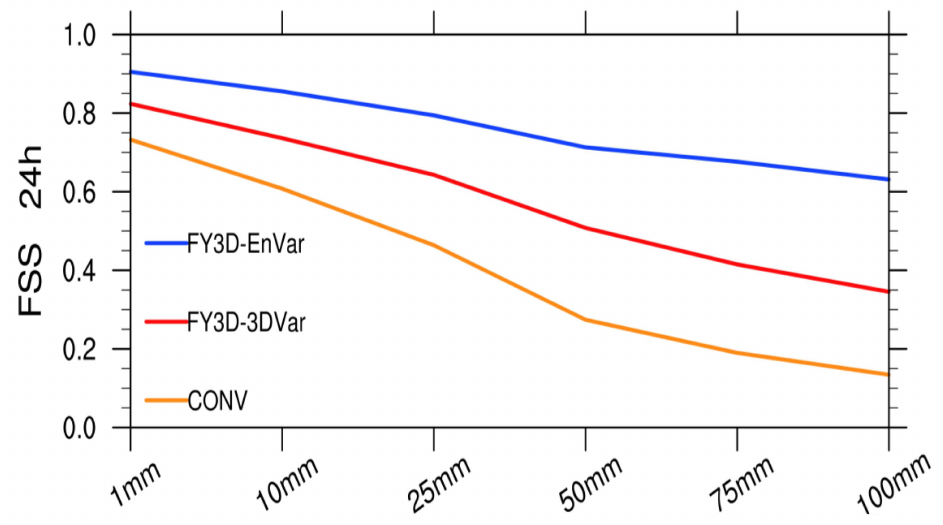
Figure 16. 24-h FSS at different